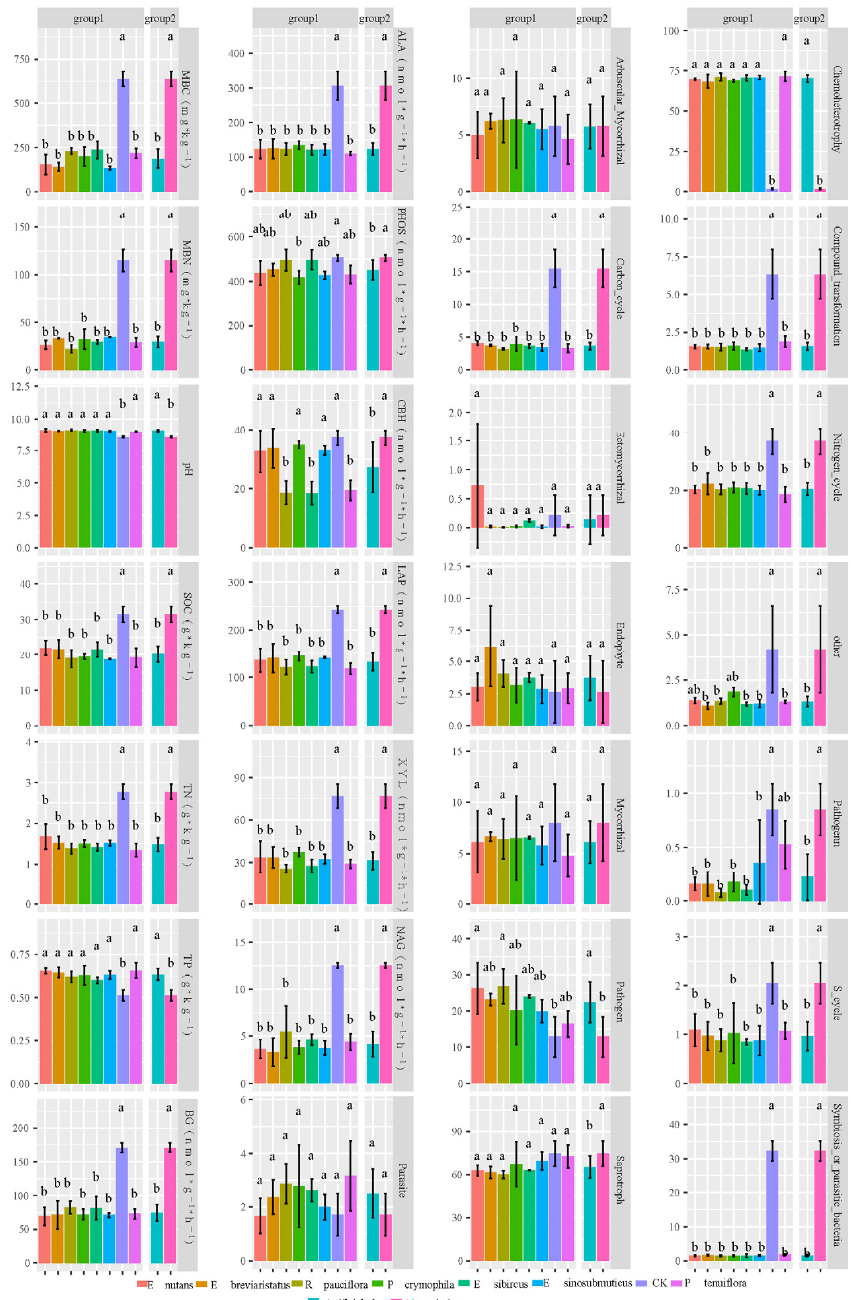
Figure 2. Soil single functions and soil pH at natural and artificial grassland. CK: Natural temperate steppe. E breviaristatus: Elymus breviaristatus . E nutants: Elymus nutans . E sibircus: Elymus sibircus . E sinosubmuticus: Elymus sinosubmuticus . P crymophila: Poa crymophila . P tenuiflora: Puccinellia tenuiflora . R pauciflora: Roegneria pauciflora . The different lowercase letters above the bars denoted significant differences ( p < 0.05